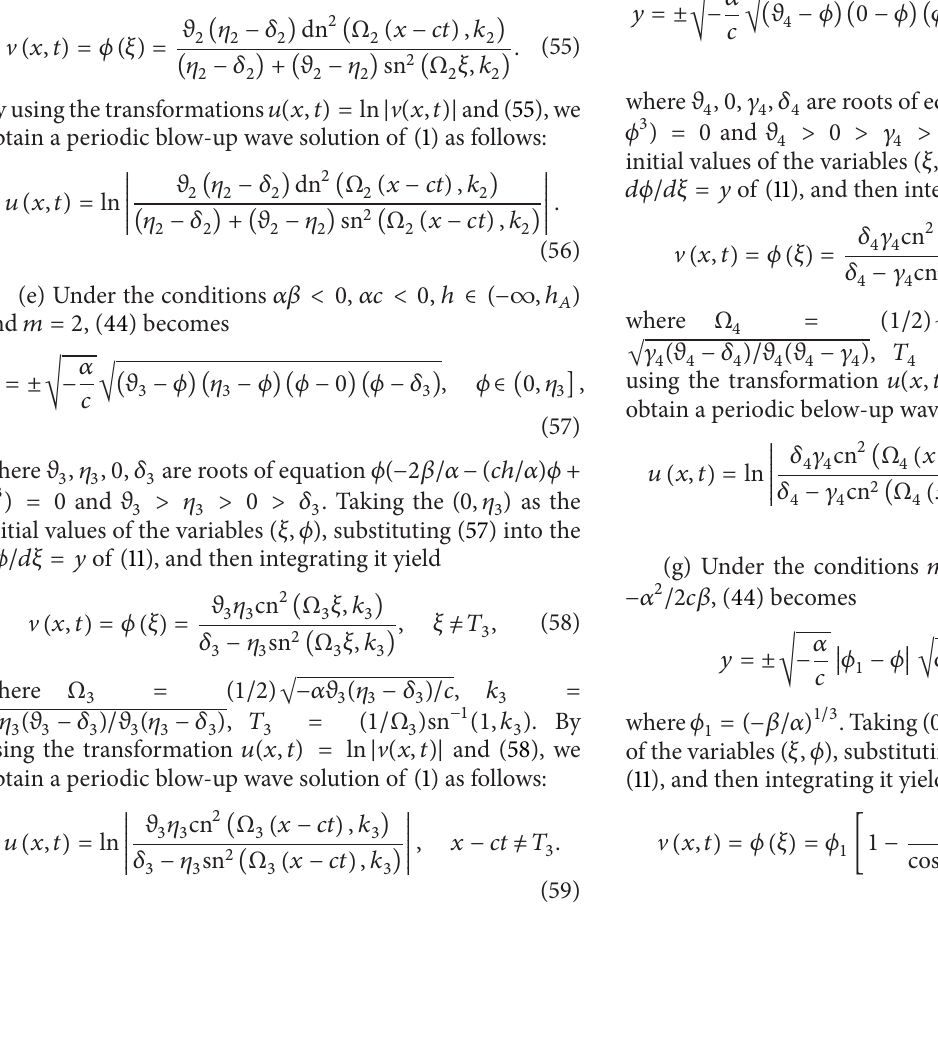
Taking the (0, 𝜗 2 ) as the initial values of the variables (𝜉, 𝜙) , substituting (54) into the 𝑑𝜙/𝑑𝜉 = 𝑦 of (11), and